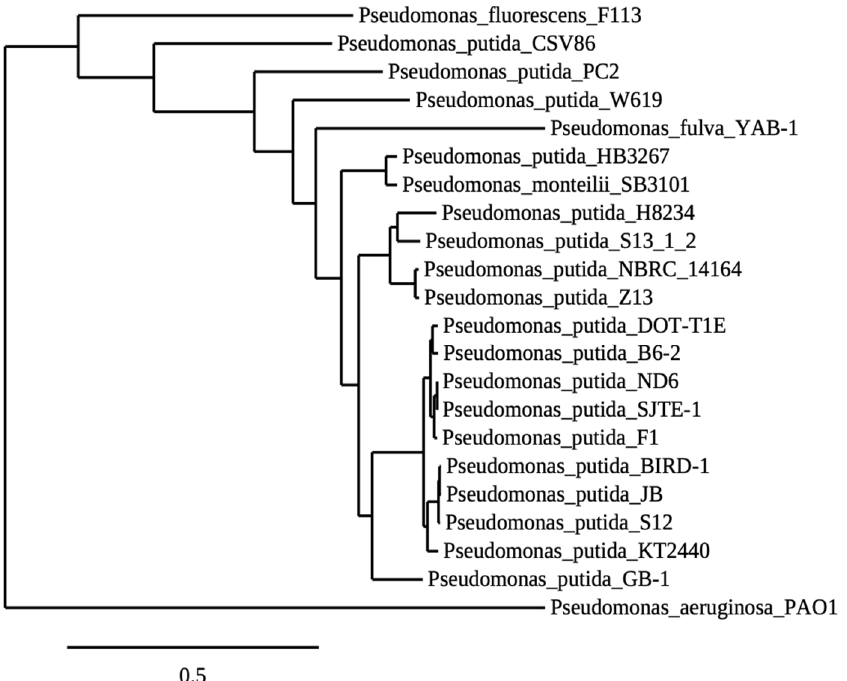
Figure 7. Maximum Likelihood Phylogenetic Reconstruction of P. putida Z13 and other Pseudomonas strains. The phylogeny was made with 952 core genes shared by all the strains. Branch support values were obtained with 100 bootstrap replicates and every node have 100% support.